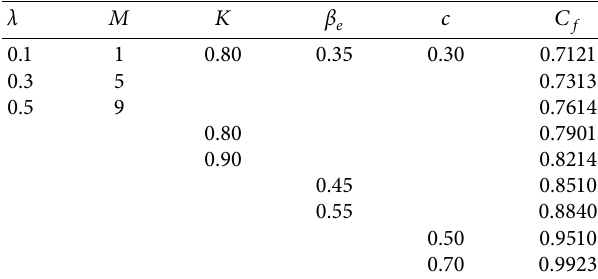
Table 5: The impact of M,K, λ , β couple stress parameter, mixed convection parameter, hall pa- rameter, and velocity ratio parameter) on skin frication for the flow problem.